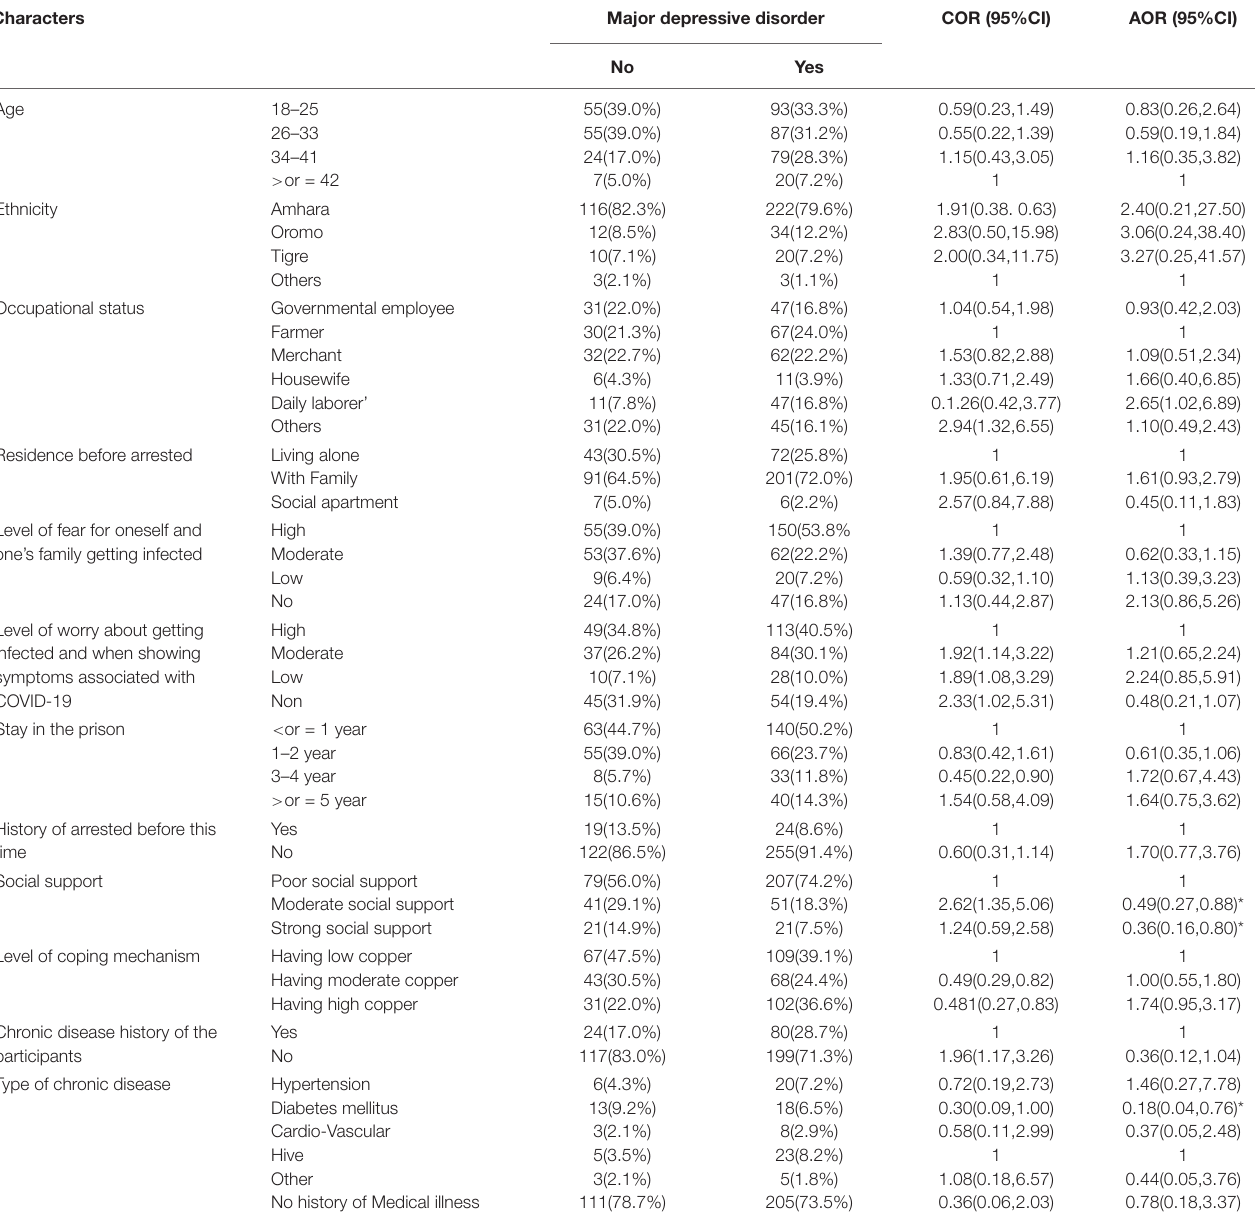
TABLE 4 | Multiple logistic regression: Factors associated independently with major depressive disorder during COVID-19 pandemic among Dessie town prisoners, in Dessie Amhara region, Northeast Ethiopia, October 2020; ( n = 420).